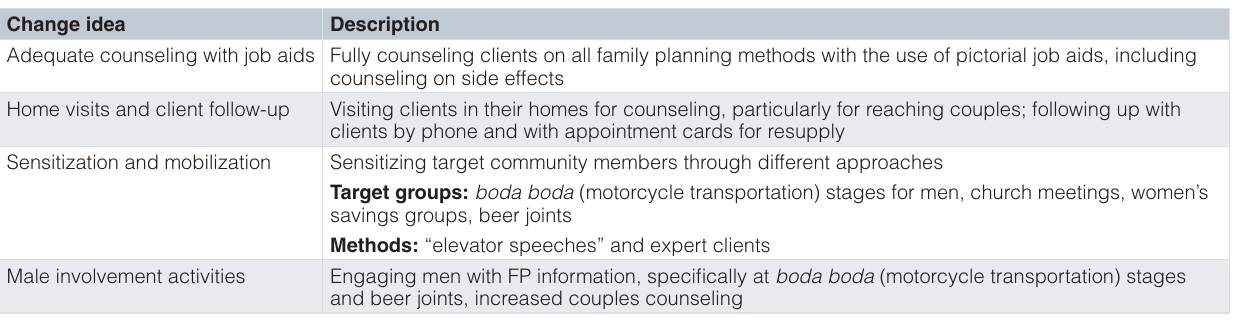
Table 3. Change ideas considered most effective by Village Health Teams. Change